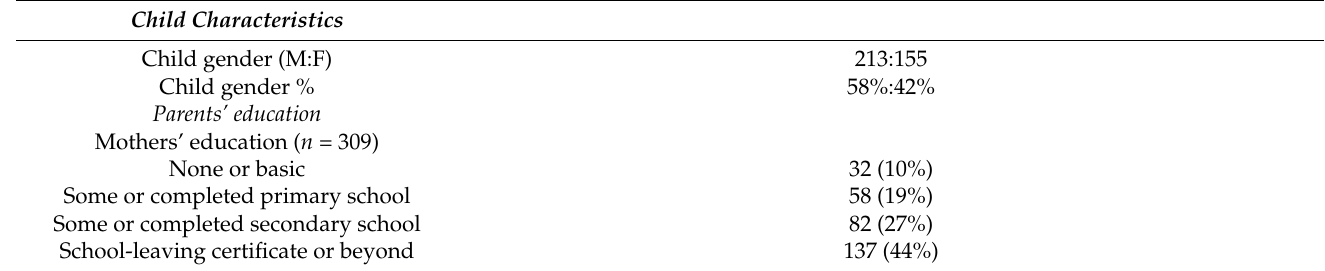
Table 1. Child and Household Characteristics. The lower portion of the table shows the changes over the three survey rounds. Only child age changed significantly (shown in